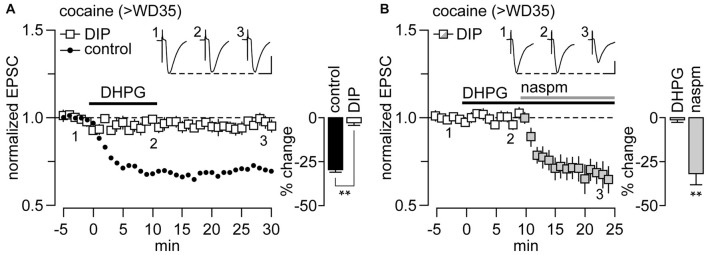
mGlu1-LTD at NAc glutamatergic synapses onto MSN recorded from rats that underwent >35 days of cocaine withdrawal (>WD35) requires the dynamin-dependent endocytosis of CP-AMPARs. (A) DHPG-induced attenuation of locally-evoked EPSC−70 mV in NAc MSNs was no longer observed when the dynamin inhibitory peptide (DIP, 2 mM) was included in the recording electrode (n = 6 cells/5 rats). Data from control internal solution recordings (from Figure 1B) were included for comparison. Inset bar graph summarizes the magnitude of EPSC suppression obtained during the last 5 min of DHPG washout (**p < 0.001, unpaired t-test). (B) While the inclusion of DIP in the recording electrode blocked the expression of DHPG-induced LTD, it did not disrupt the inhibitory effect of the CP-AMPAR antagonist 1-naphthyl acetyl spermine (NASPM; 100 μM) on MSN EPSC−70 mV amplitude (n = 7 cells/7 rats). Inset bar graph summarizes the extent of EPSC suppression recorded during the last 5 min of DHPG bath application alone and with the addition of NASPM (**p < 0.001 vs. baseline, paired t-test). Calibration bars for example traces: 100 pA, 25 ms.